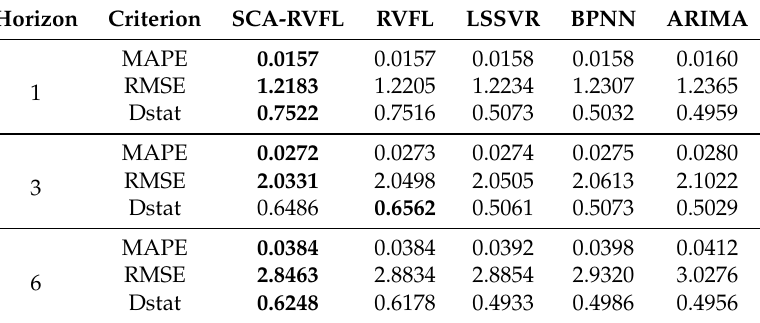
Table 2. Results of single